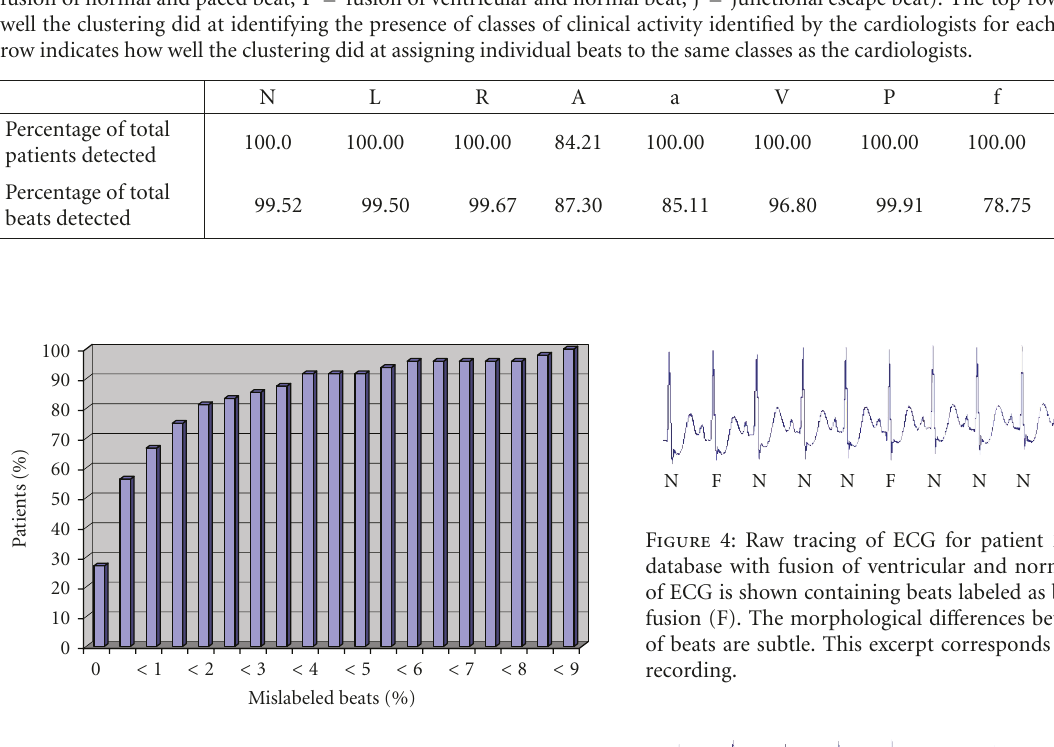
Figure 3: Mislabeling error: over a quarter of the patients had no mislabeling errors using our clustering approach, over 65% had less than 1% mislabeled beats relative to cardiologist labels.